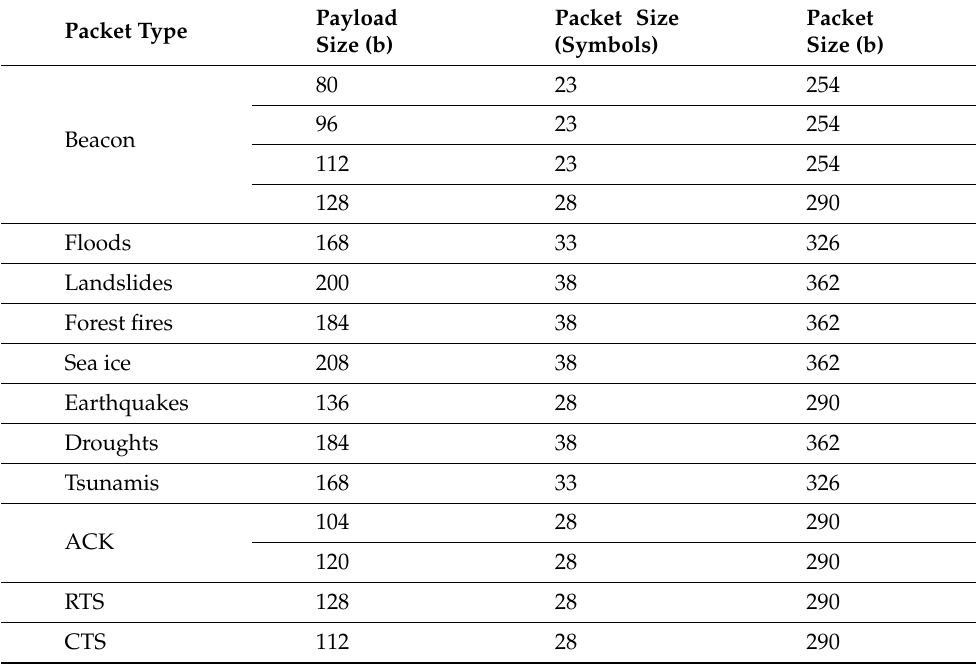
Table 3. Total packet sizes of all messages sent in the